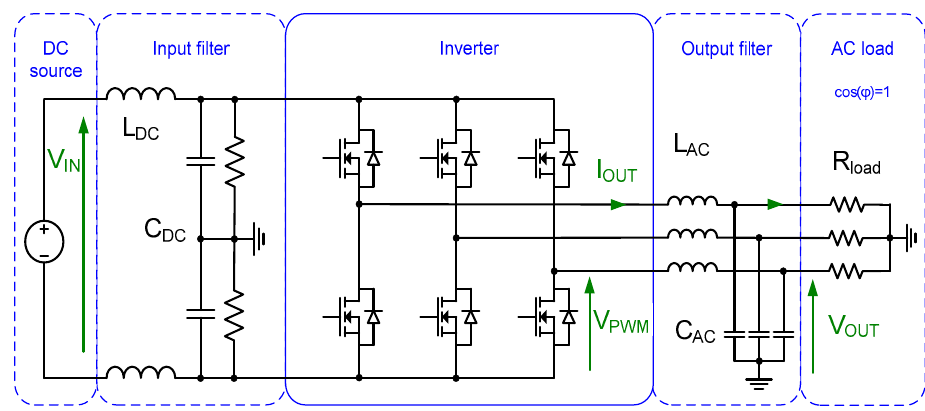
Figure 5. Schematic of the pulse width modulation (PWM) inverter; V IN is the input DC bus, V OUT is measured with respect to a neutral point (common with the DC bus middle point), and V PWM is the switch voltage.